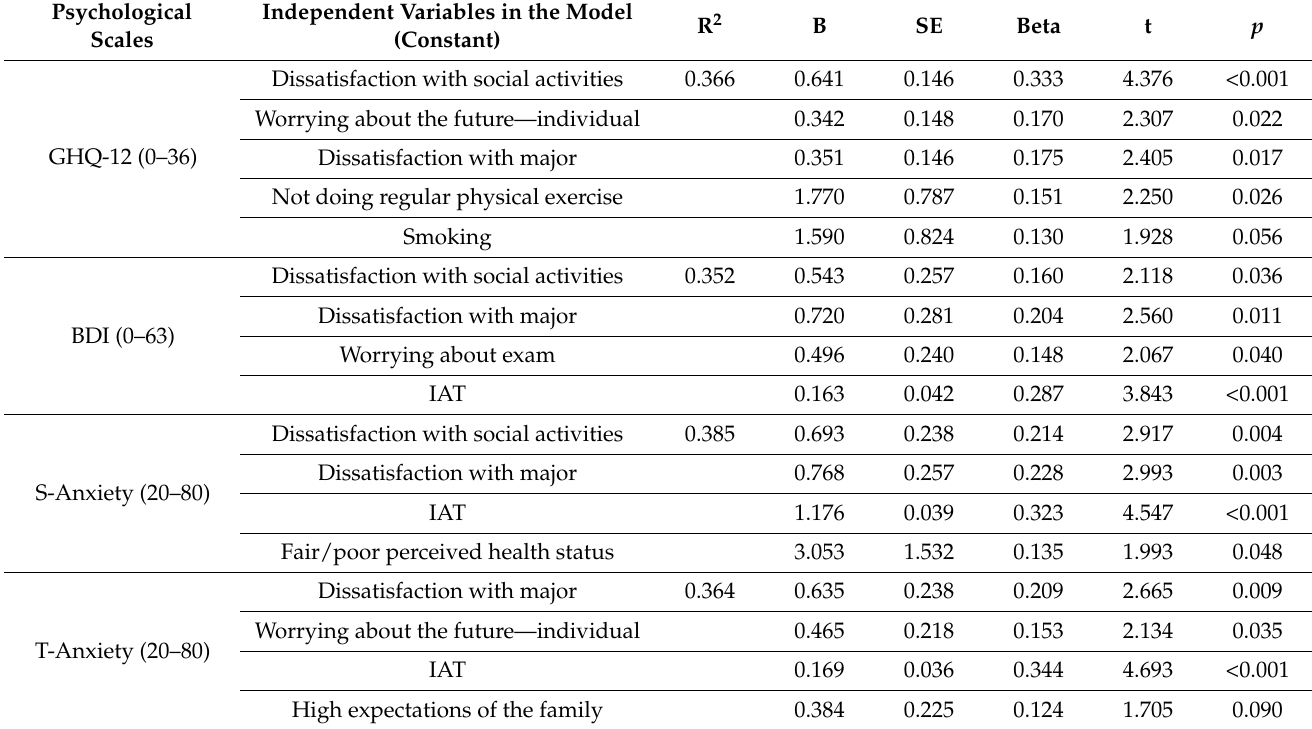
Table 5. Results of multiple regression analyses for nursing